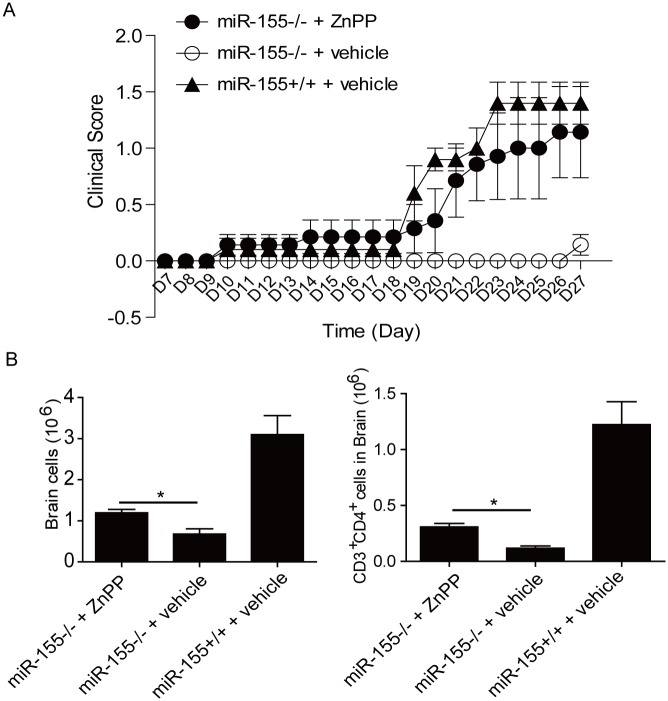
The failure of miR-155
-/- CD4+ T cells to mediate EAE can be rescued by inhibiting HO-1.(A) MiR-155
-/- CD4+ T cells or miR-155
+/+ CD4+T cells were transferred in Rag1
-/- congenic recipients one day before EAE induction. Animals received daily ZnPP treatment or vehicle alone. Disease severity was scored based upon clinical symptoms. n = 7 mice per group. The results are representative of two independent experiments. (B) Total numbers of live cells (Left) and numbers of CD3+CD4+ cells (Right) in brain 27 days after immunization. *: p<0.05. Data are shown as mean ±SEM. n = 7 mice per group. The results are representative of two independent experiments.